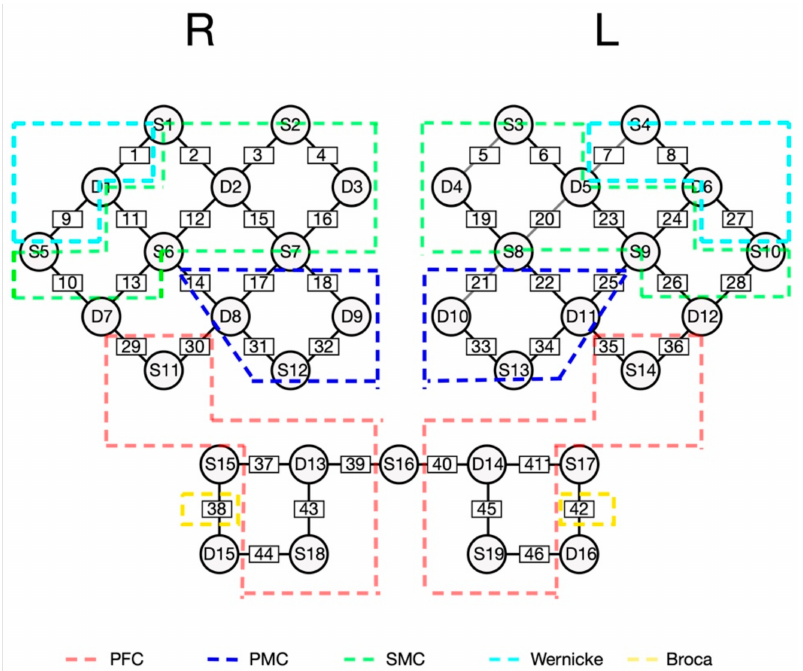
Figure 2. The channel attrition of fNIRS. PFC = pre-frontal cortex; PMC = pre-motor cortex; SMC = sensorimotor